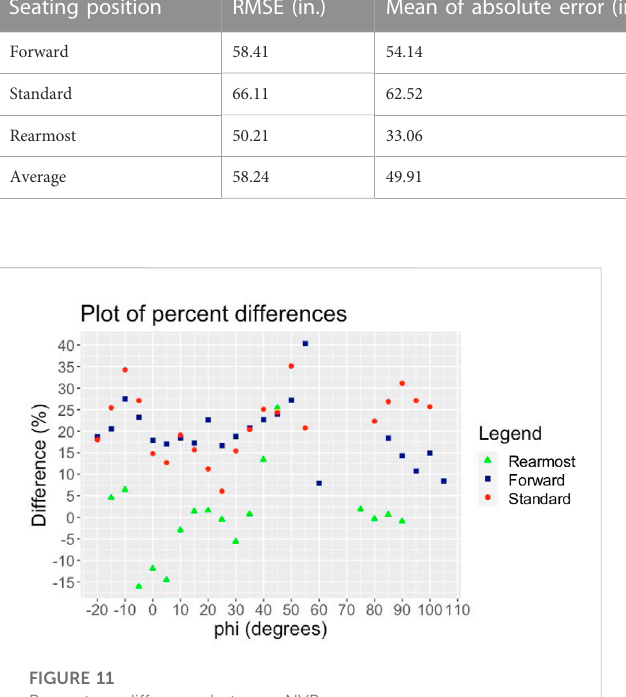
FIGURE 11 Percentage difference between